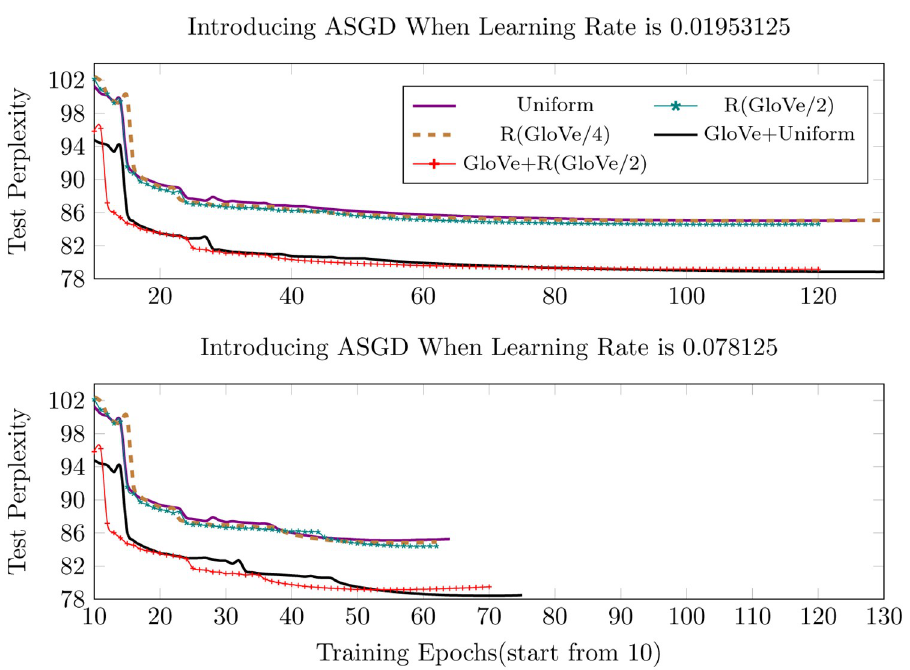
Fig 4. Test perplexity of introducing ASGD at different learning